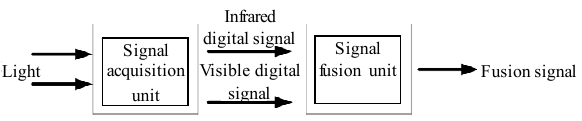
Fig. 1 Imaging process composition of the sensor device.